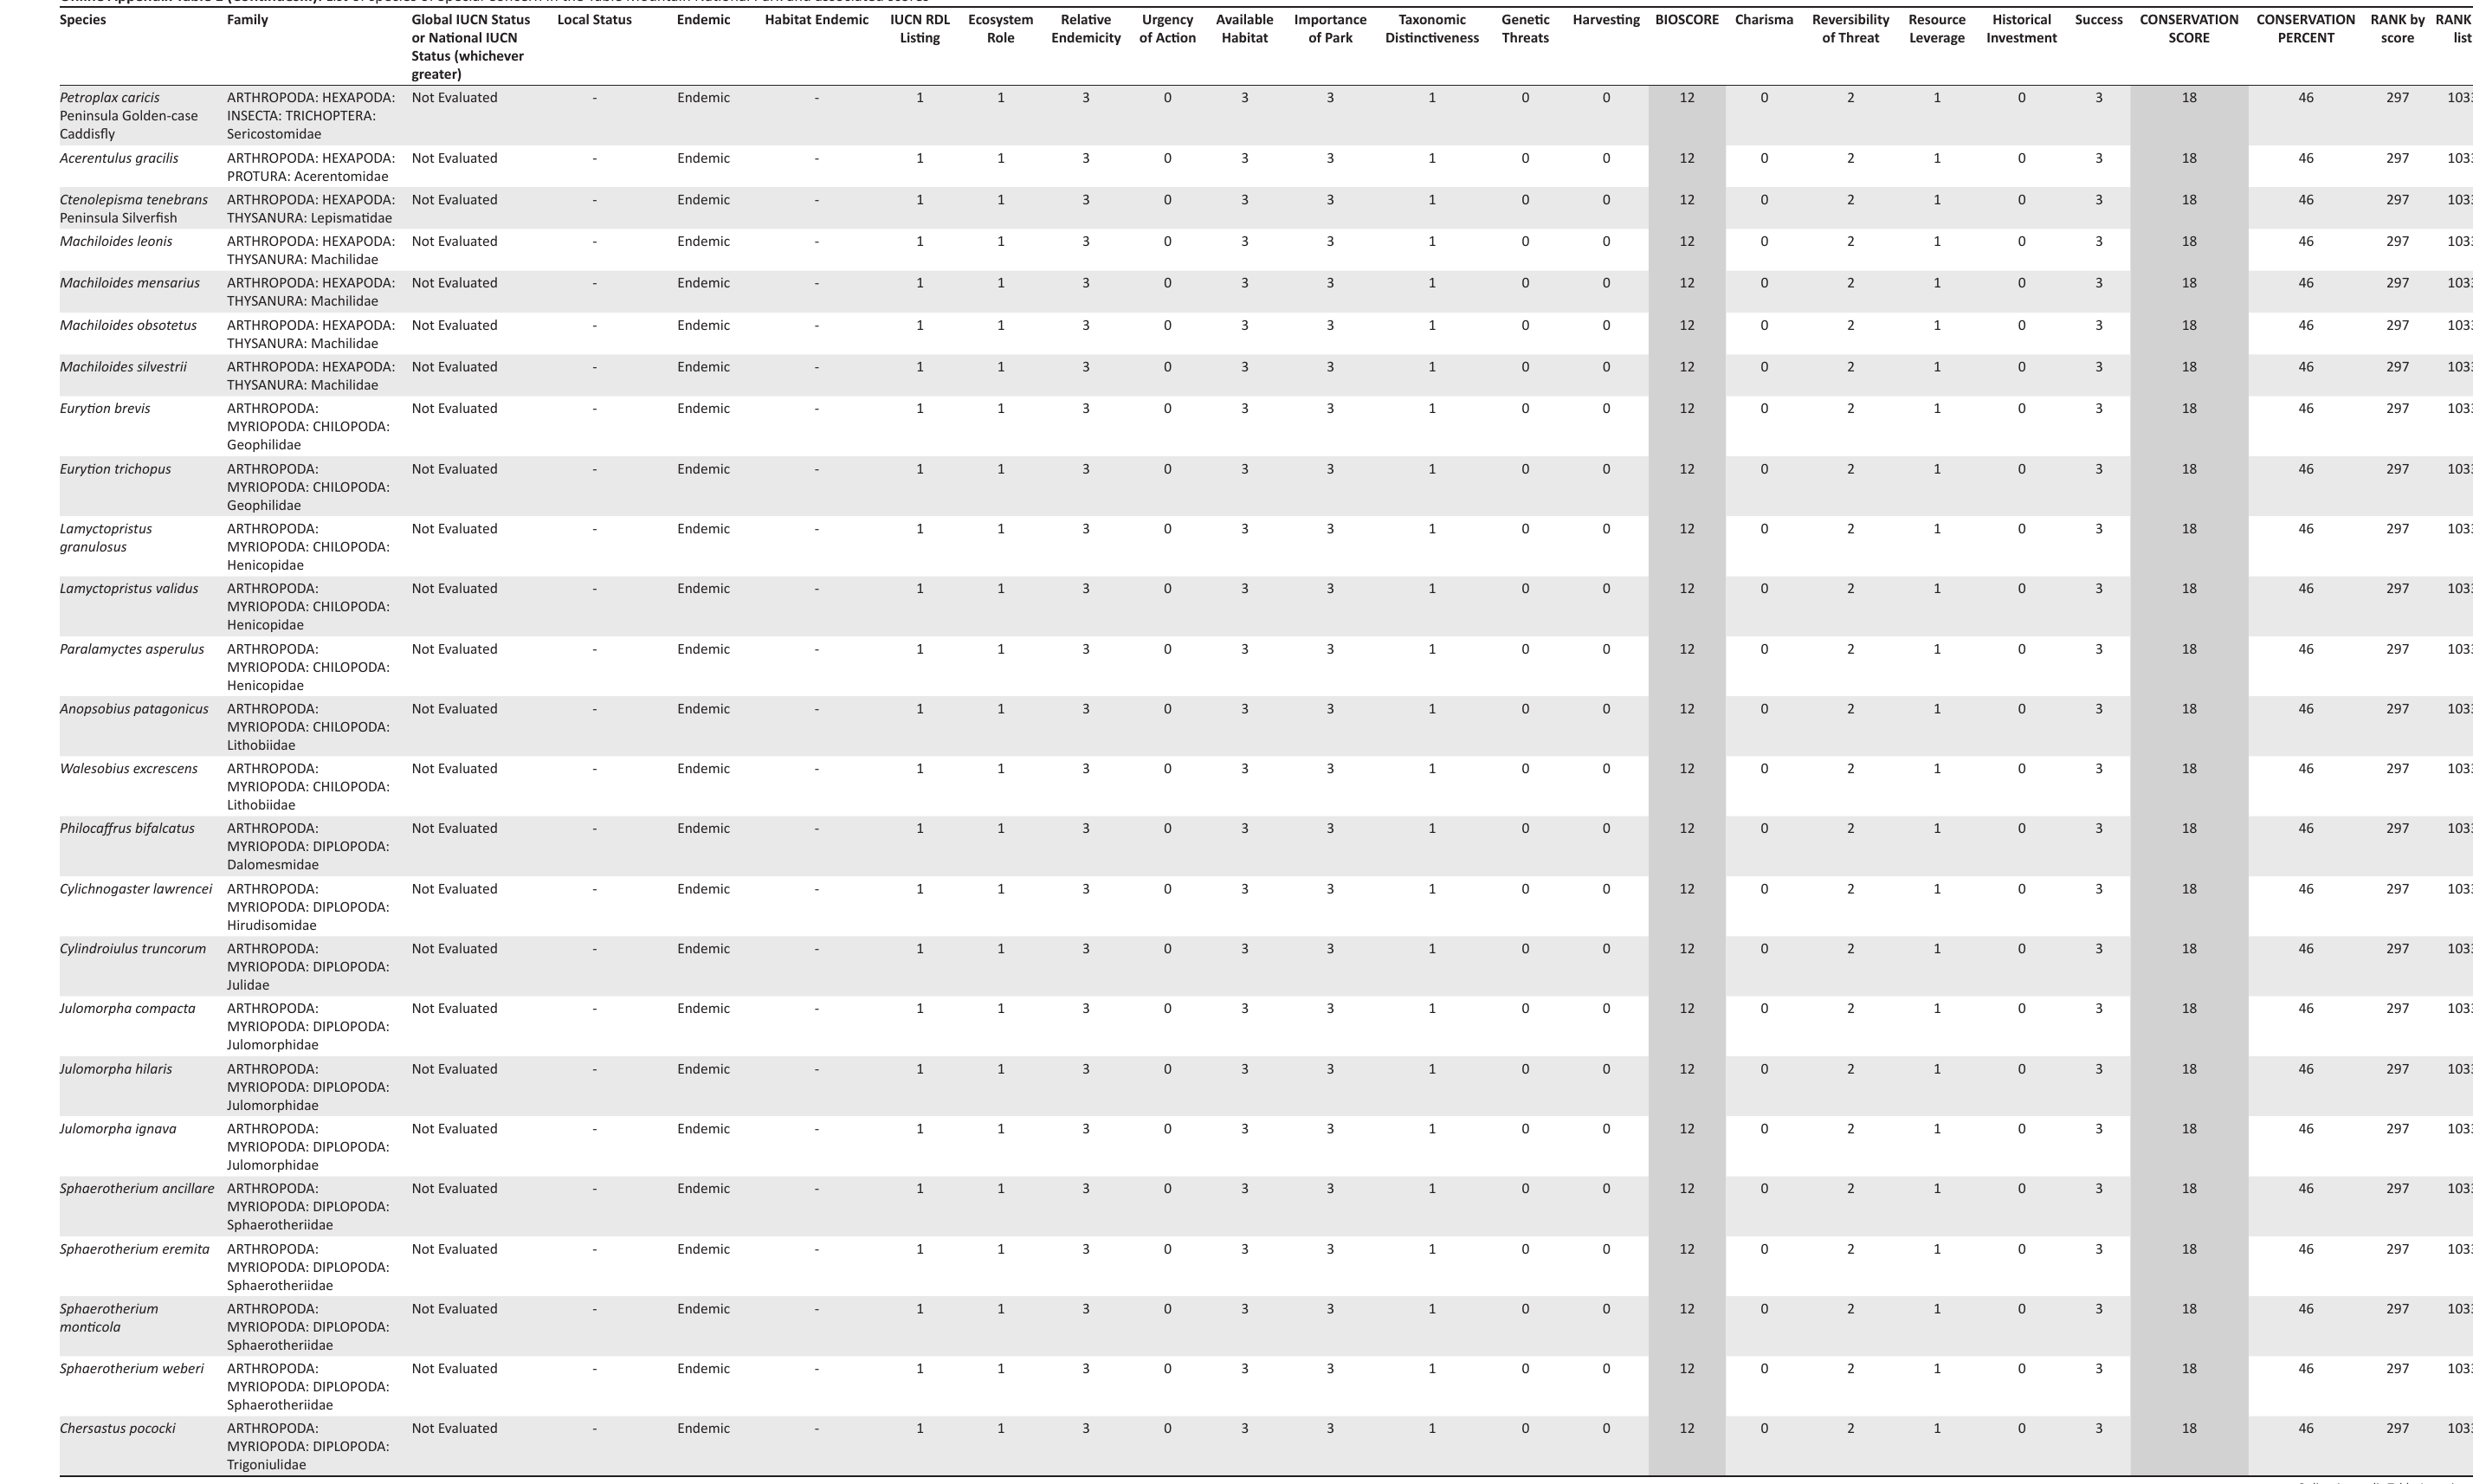
Online Appendix Table 1 (Continues...): List of species of Special Concern in the Table Mountain National Park and associated scores